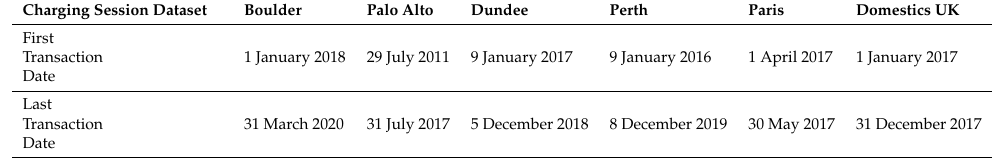
Table 5. Overall statistics and high-level information for the six datasets in